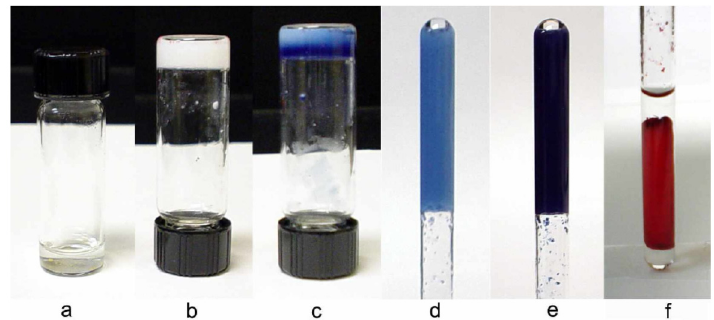
Figure 61. The gel formed by compound 105f in ethanol at below10 mg/mL. ( a ) a clear solution of the heated gelator, ( b ) a stable gel after cooling to room temperature, ( c ) the gel turned blue after irradiation of UV lamp from the top of the glass vial, ( d ) the gel was transferred to a quartz tube and irradiated for 1 min, ( e ) the same gel turned dark blue after UV treatment for 3 min, ( f ) the red gel was obtained by heating the gel in ( e ). Reprinted with permission from [31]. Copyright 2011 Beilstein-Institut.